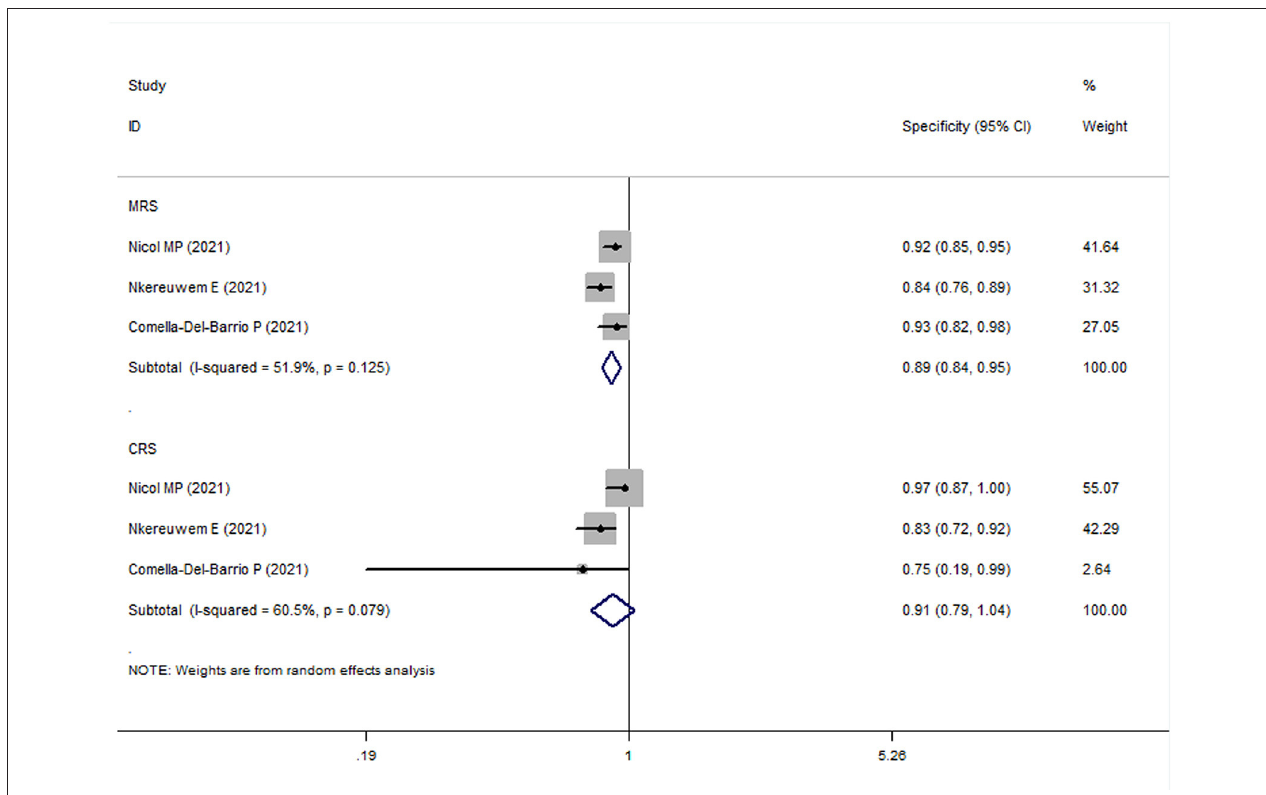
FIGURE 6 | The meta-analysis results of the specificity of FujiLAM in the diagnosis of pediatric patients with tuberculosis.